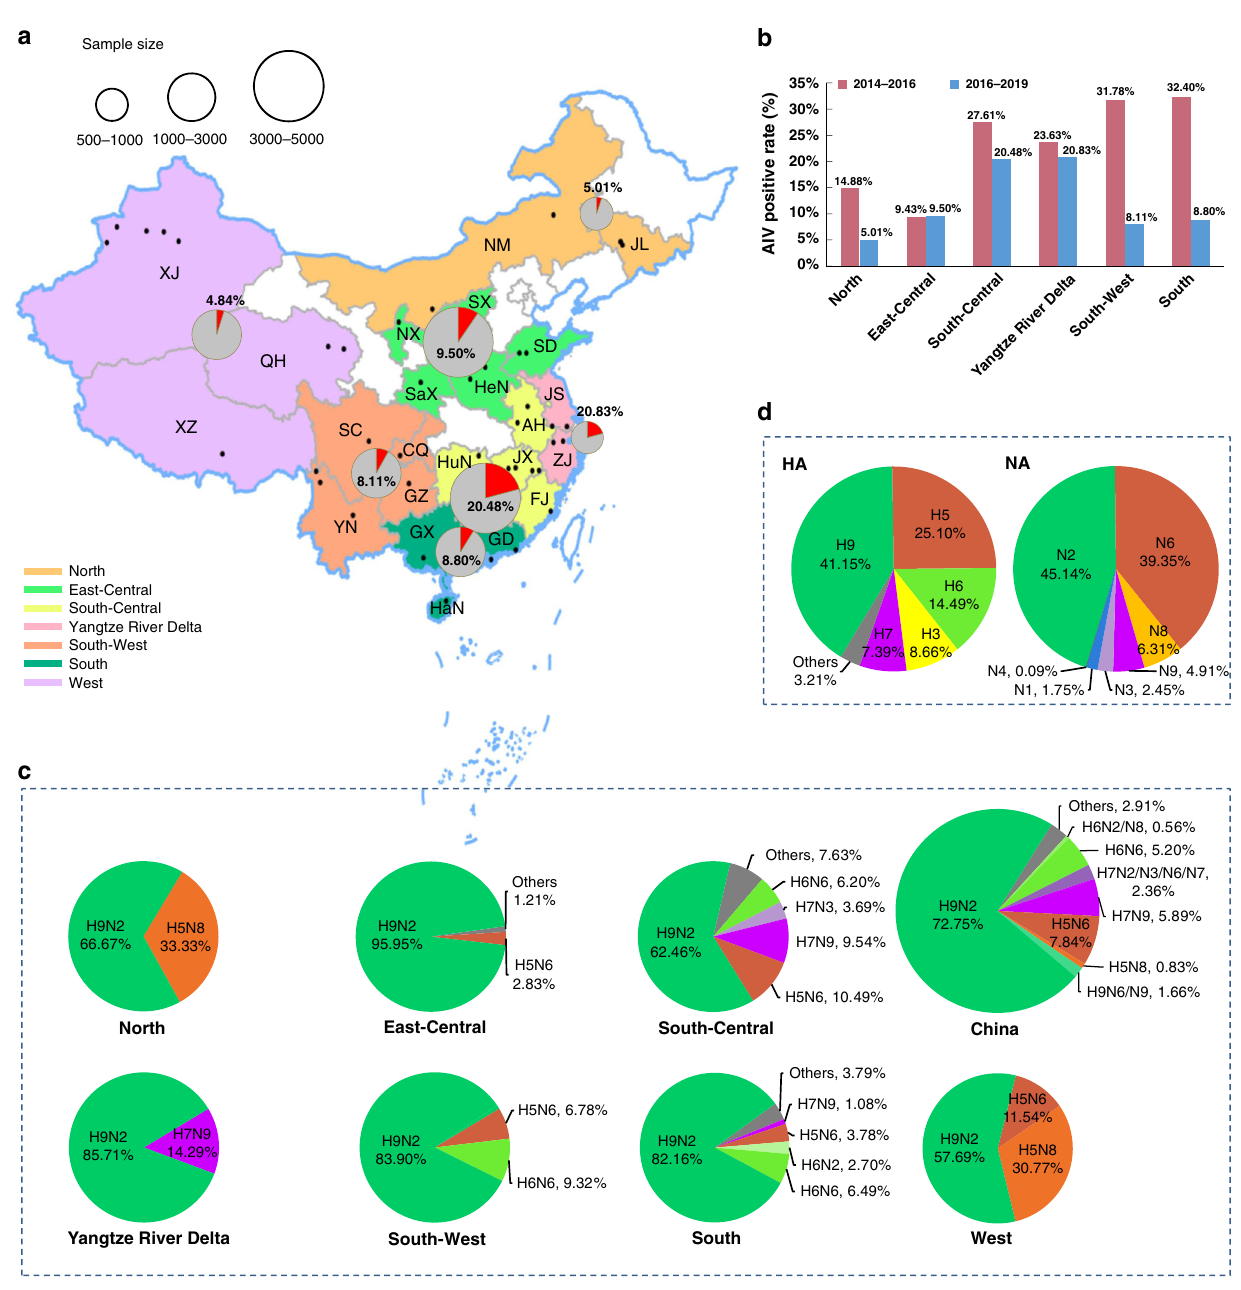
Fig. 1 The distribution of sampling sites and avian in fl uenza viruses (AIVs) in LPMs across China. a Map of the AIV sampling sites and isolation rates in LPMs. AIV surveillance sites in 37 cities (indicated by black dots) of 23 provinces or municipalities or minority autonomous regions in China are divided into seven different regions: North (Inner Mongolia, NM and Jilin, JL; orange), East-Central (Shanxi, SX; Ningxia, NX; Shandong, SD; Shaanxi, SaX and Henan, HeN; light green), South-Central (Anhui, AH; Hunan, HuN; Jiangxi, JX and Fujian, FJ; yellow), Yangtze River Delta (Jiangsu, JS and Zhejiang, ZJ; pink), South-West (Sichuan, SC; Chongqing, CQ; Yunnan, YN; and Guizhou, GZ; orange red), South (Guangxi, GX; Guangdong, GD and Hainan, HaN; dark green), and West (Xinjiang, XJ; Qinghai, QH; and Xizang, XZ; light purple). The red portion in each pie chart indicates the isolation rate of AIV in this region. The standard map was downloaded from Ministry of Natural Resources of the People ’ s Republic of China (http://bzdt.ch.mnr.gov.cn/), and the collection sites of LPMs in our study were marked on the map using ArcGIS. b AIV positive rates of the present study (2016 – 19) and the previous study in 2014 – 16 13 . The regions included North, East-Central, South-Central, Yangtze River Delta, South-West, and South. The numbers on the column represent the AIV isolation rate. c Subtype proportions of AIVs in the pure isolates with a single HxNy subtype. d The proportion of HA and NA from the impure isolates containing over two HA or NA subtypes. Source data are provided as a Source Data fi